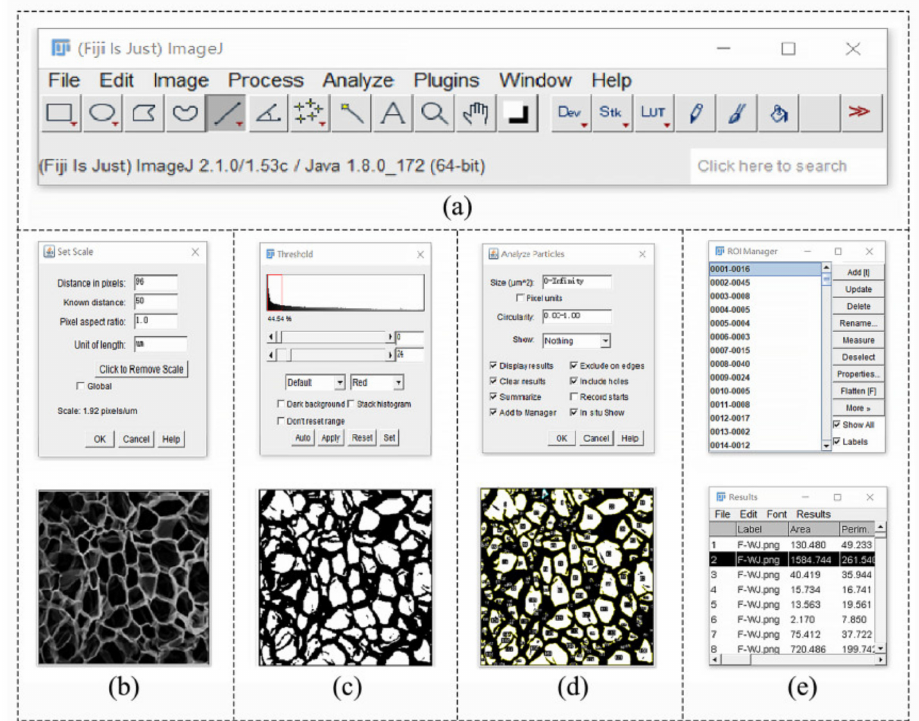
Figure 3. Image process of dried jujube slices (( a ): main menu; ( b ): scale setting; ( c ): threshold setting; ( d ): particle analysis; ( e ):